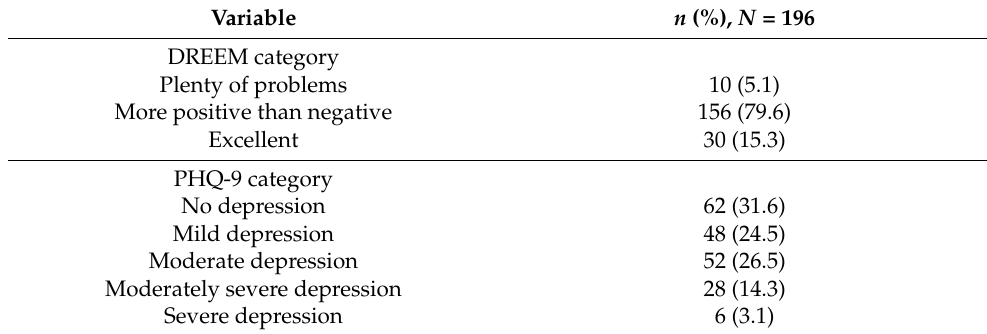
Table 2. DREEM and PHQ-9